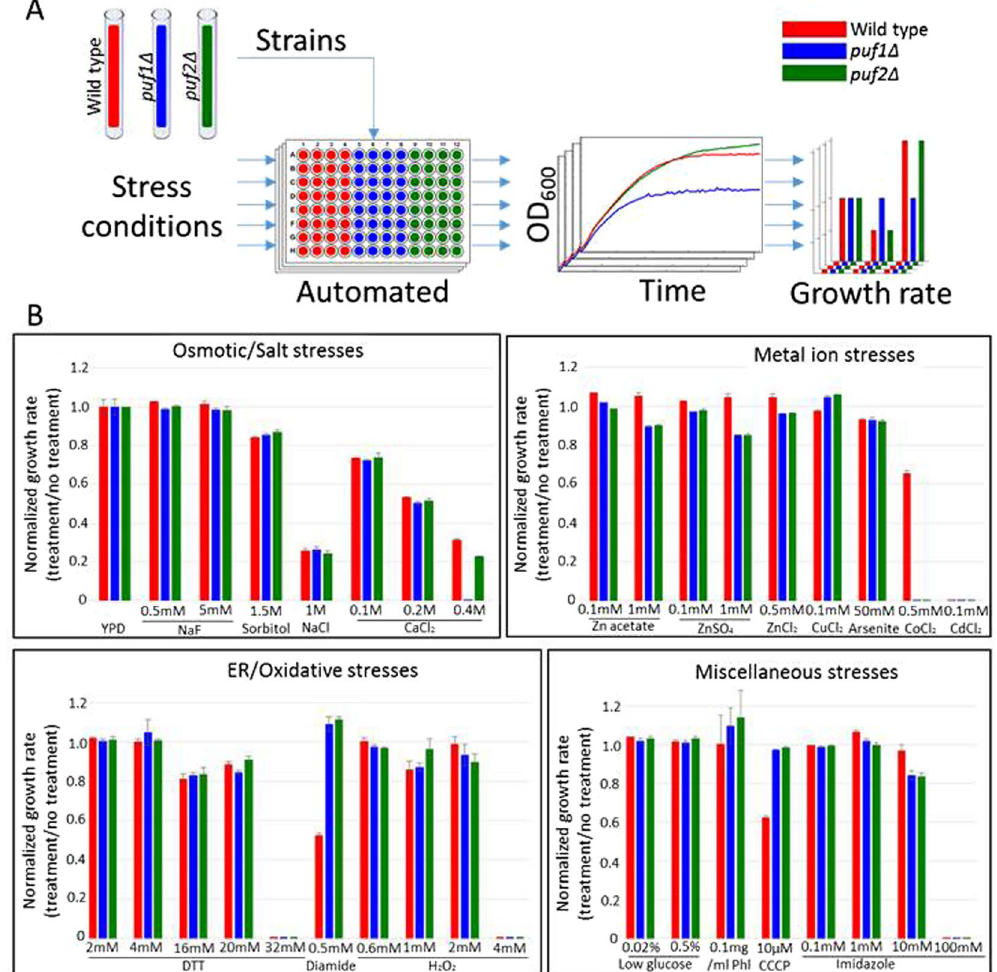
Figure 1. Stress conditions screen of puf1 Δ and puf2 Δ strains growth rate. ( A ) Scheme of the screen. Yeasts (yA635, yA636 and yA637) were grown in YPD to the mid- logarithmic phase and aliquoted to 96-wells plates containing media with the indicated supplements. Cells were grown for several hours, and OD 600 was measured automatically every 15 min. Growth curves were acquired, and growth rates were calculated and normalized to untreated cells. ( B ) Representative stress conditions were divided into five general groups, and normalized growth rates were calculated for each stress condition. Error bars are + 1 standard deviation, n ≥ 3. Phl-1,10-